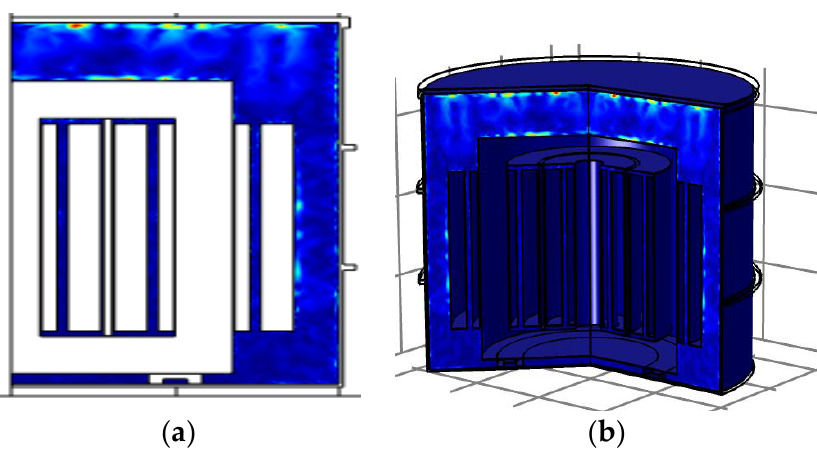
Figure 19. Surface gas velocity magnitude (m/s) for ( a ) 2D and ( b ) 2D axial symmetry analysis.